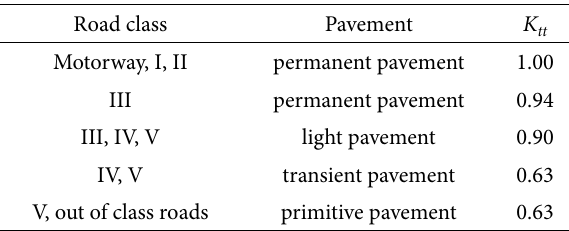
Table 8. Pavement strength factors according Procedure